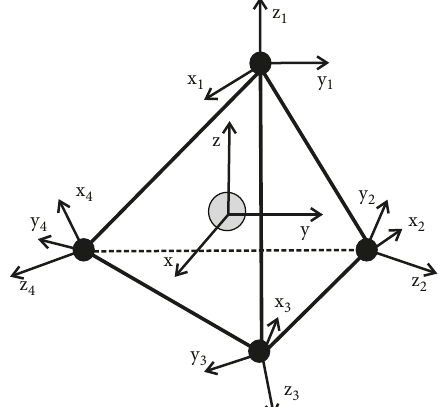
Figure 1: Basis set for vibrations in tetrahedral molecule. 𝑥 𝑖 , 𝑦 𝑖 , and 𝑧 𝑖 are atomic